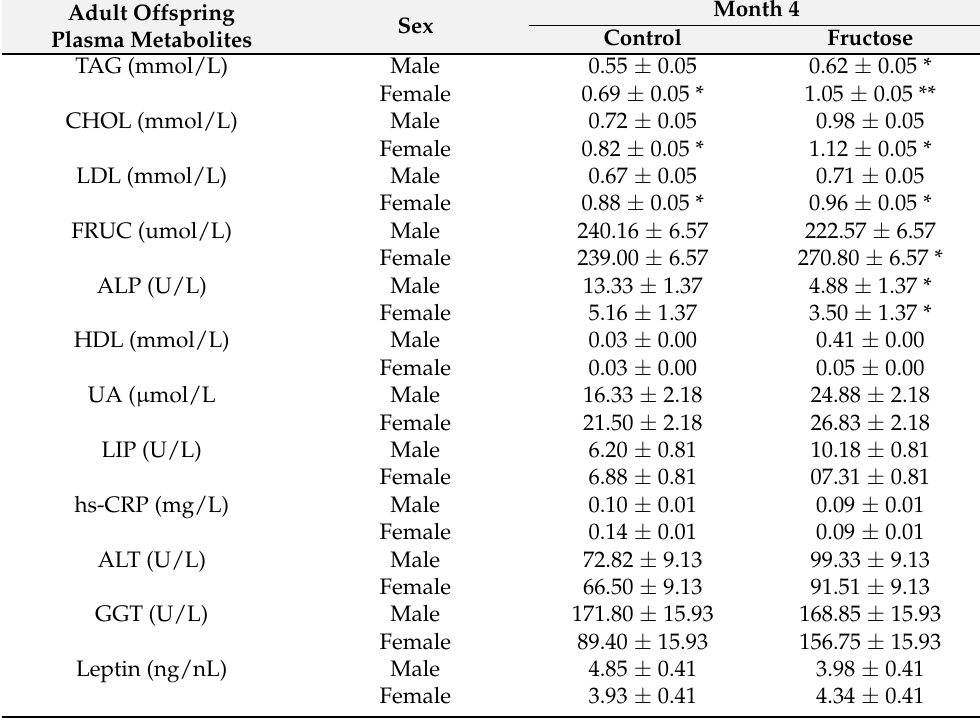
Table 1. Adult offspring plasma metabolites at month 4.